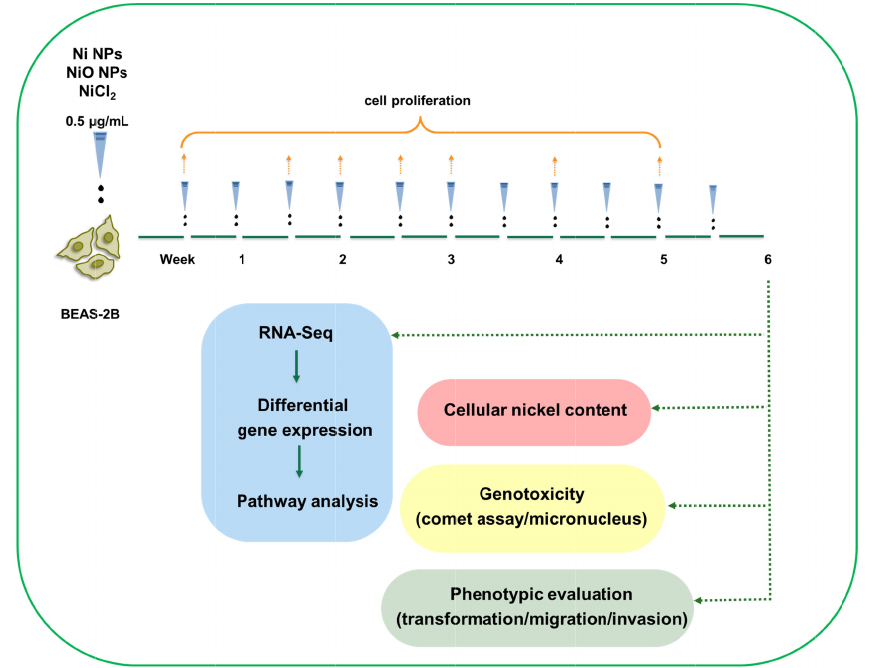
Figure 1. Low-dose, long-term exposure to nickel containing nanoparticle: experimental design. BEAS-2B cells were exposed to low doses (0.5 µ g / mL) of Ni NPs, NiO NPs and NiCl 2 as ion control over 6 weeks, with cells being split and cells re-exposed twice a week. During the six-week exposure, cell proliferation was assessed on a weekly basis. At the end of the six-week exposure, RNA sequencing was performed together with phenotypic evaluation (cell transformation, cell migration and cell invasion), genotoxicity (comet assay / micronucleus test) and cellular nickel